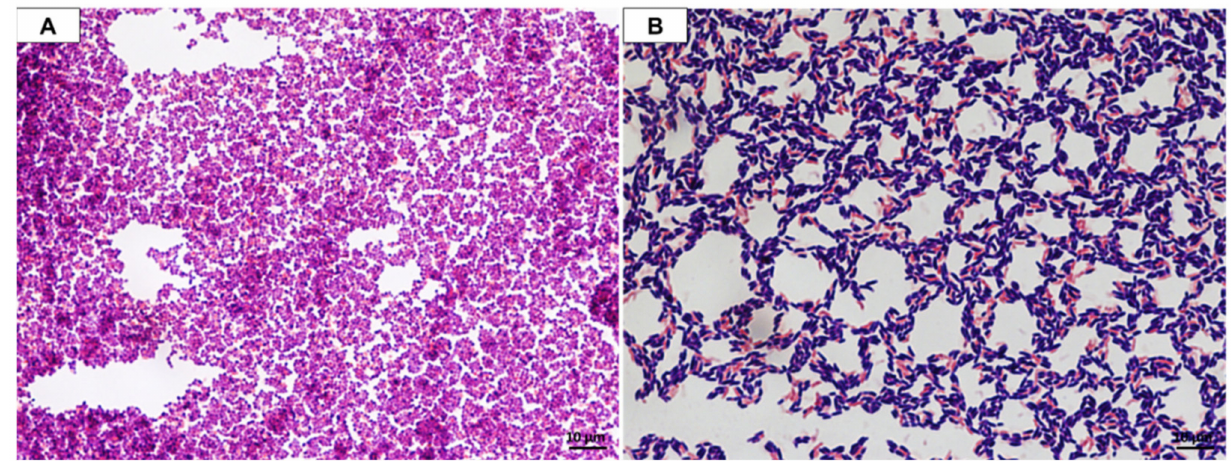
Figure 1. Optical microscope photos of the Gram staining of the tested strains: ( A )— Lactococcus lactis ; ( B )— Weissella cibaria